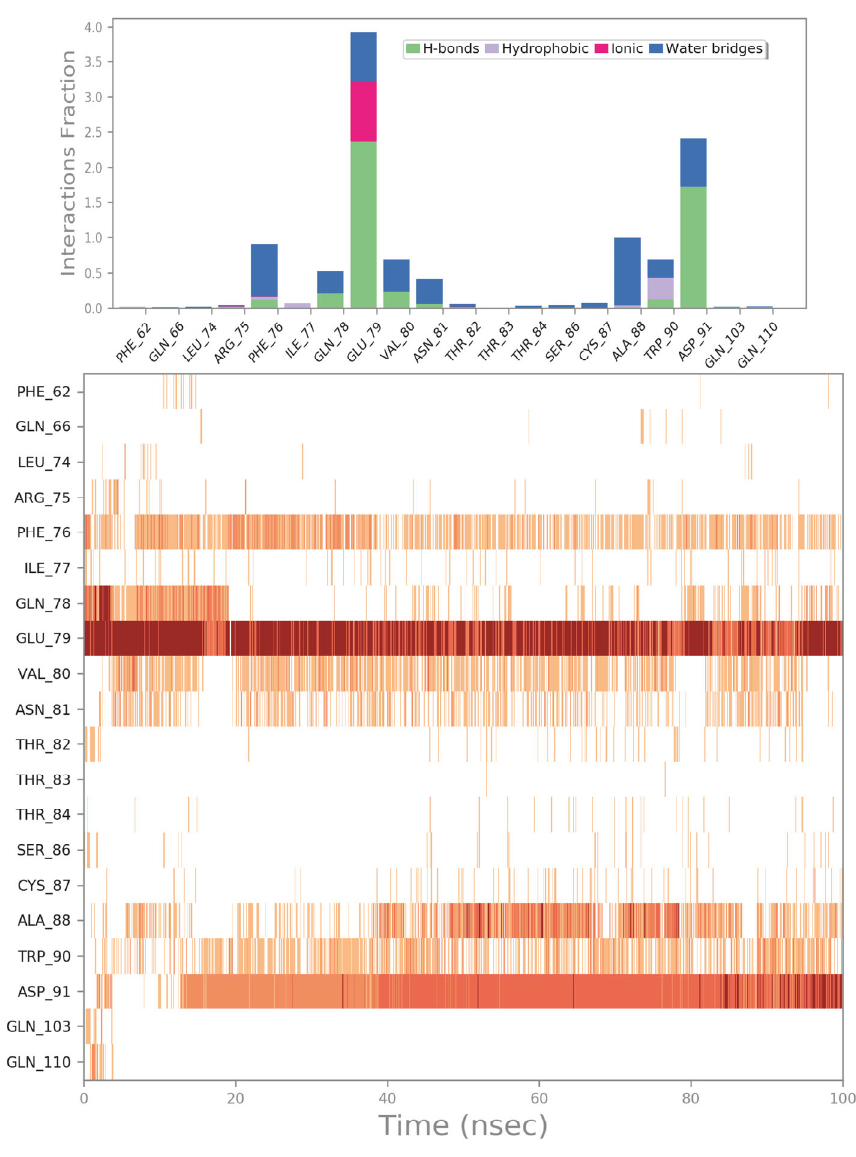
Figure 10. Setmelanotide monitored during the MD run. The interactions can be grouped into four types: H bonds (green), hydrophobic (grey), ionic (magenta), and water bridges (blue). The subsequent diagram of the figure illustrates a timeline description of the main interactions. A darker hue of orange indicates that some residues make many distinct contacts with the ligand (Maestro, Schrödinger LLC, release 2020-3).